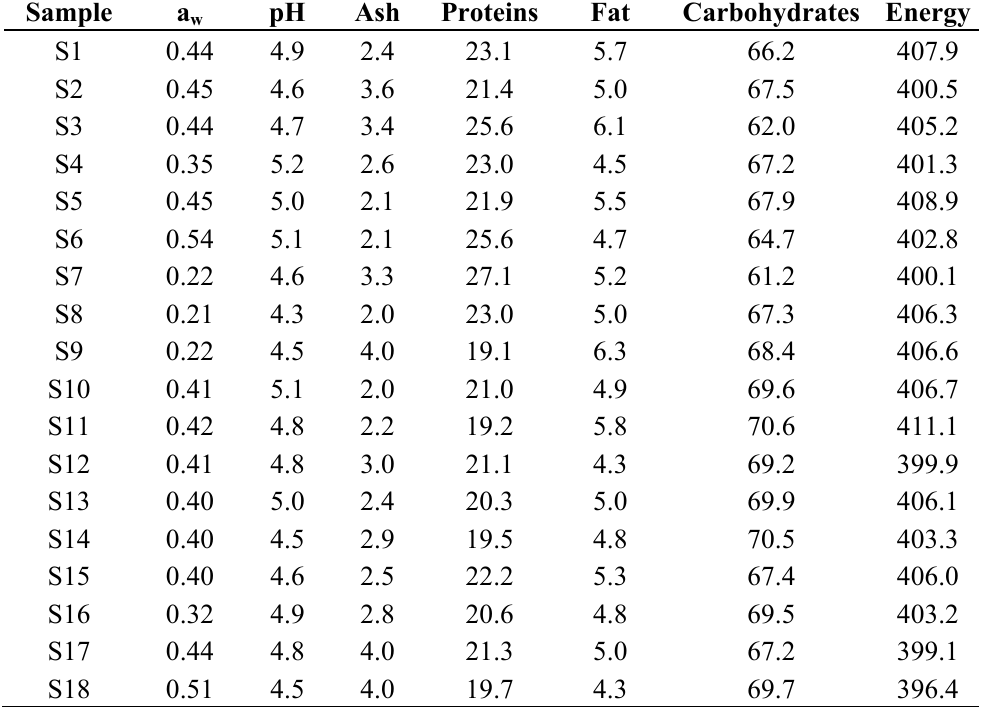
Table 3. Physico-chemical, nutritional and energetic values of organic bee pollen samples.